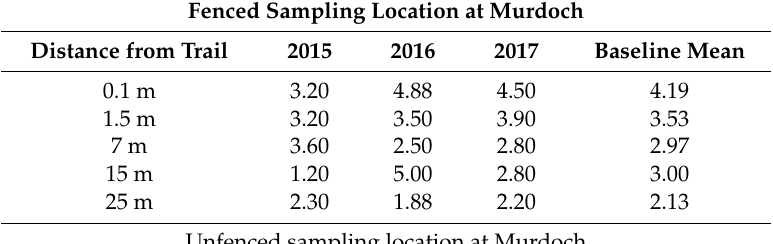
Table 1. Annual mean values for understory structure at each of the five sampling locations calculated from the two replicates of five transects sampled each year and baseline mean values for the understory structure calculated from the annual means. Reported values are the means of the semiquantitative measure of the highest row (0 to 10) that had indigenous vegetation in every